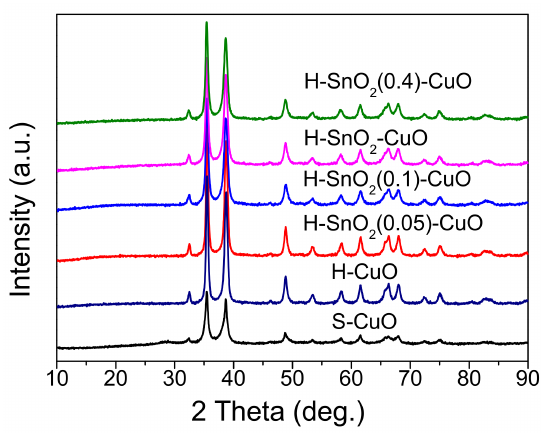
Figure 2. XRD patterns of all as-obtained samples.